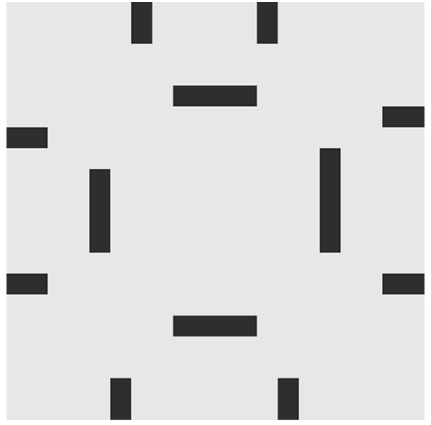
Figure 6. Training environment—20 by 20.